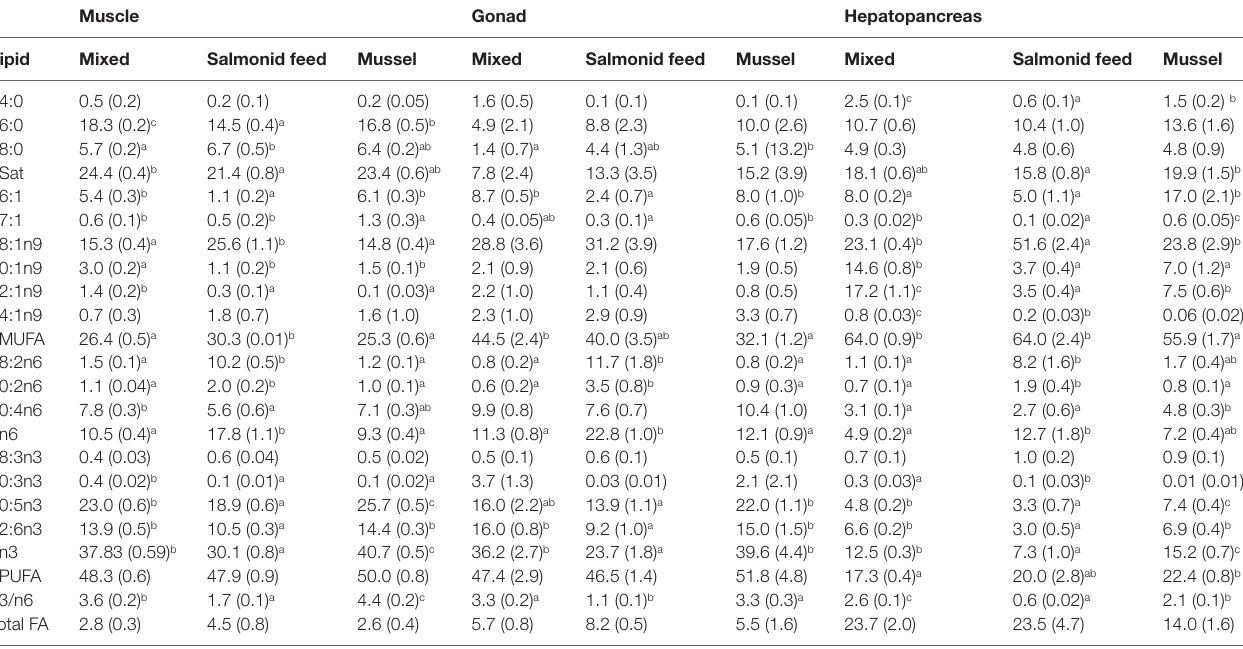
TABLE 1 | Fatty acid profiles of muscle, gonad and hepatopancreas of rock crabs, Cancer irroratus , fed different experimental diets. Muscle Gonad Lipid Mixed Salmonid feed Mussel Mixed Salmonid feed Mussel Mixed Salmonid feed